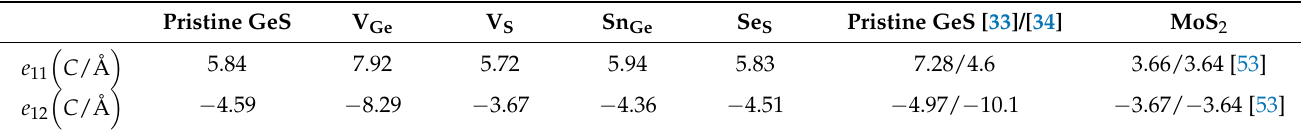
Table 3. Piezoelectric stress coefficients e ij for pristine GeS, GeS with vacancies (V Ge , V S ), and GeS with substitutional atoms (Sn Ge , Se S ) compared with previous studies for pristine GeS and MoS 2